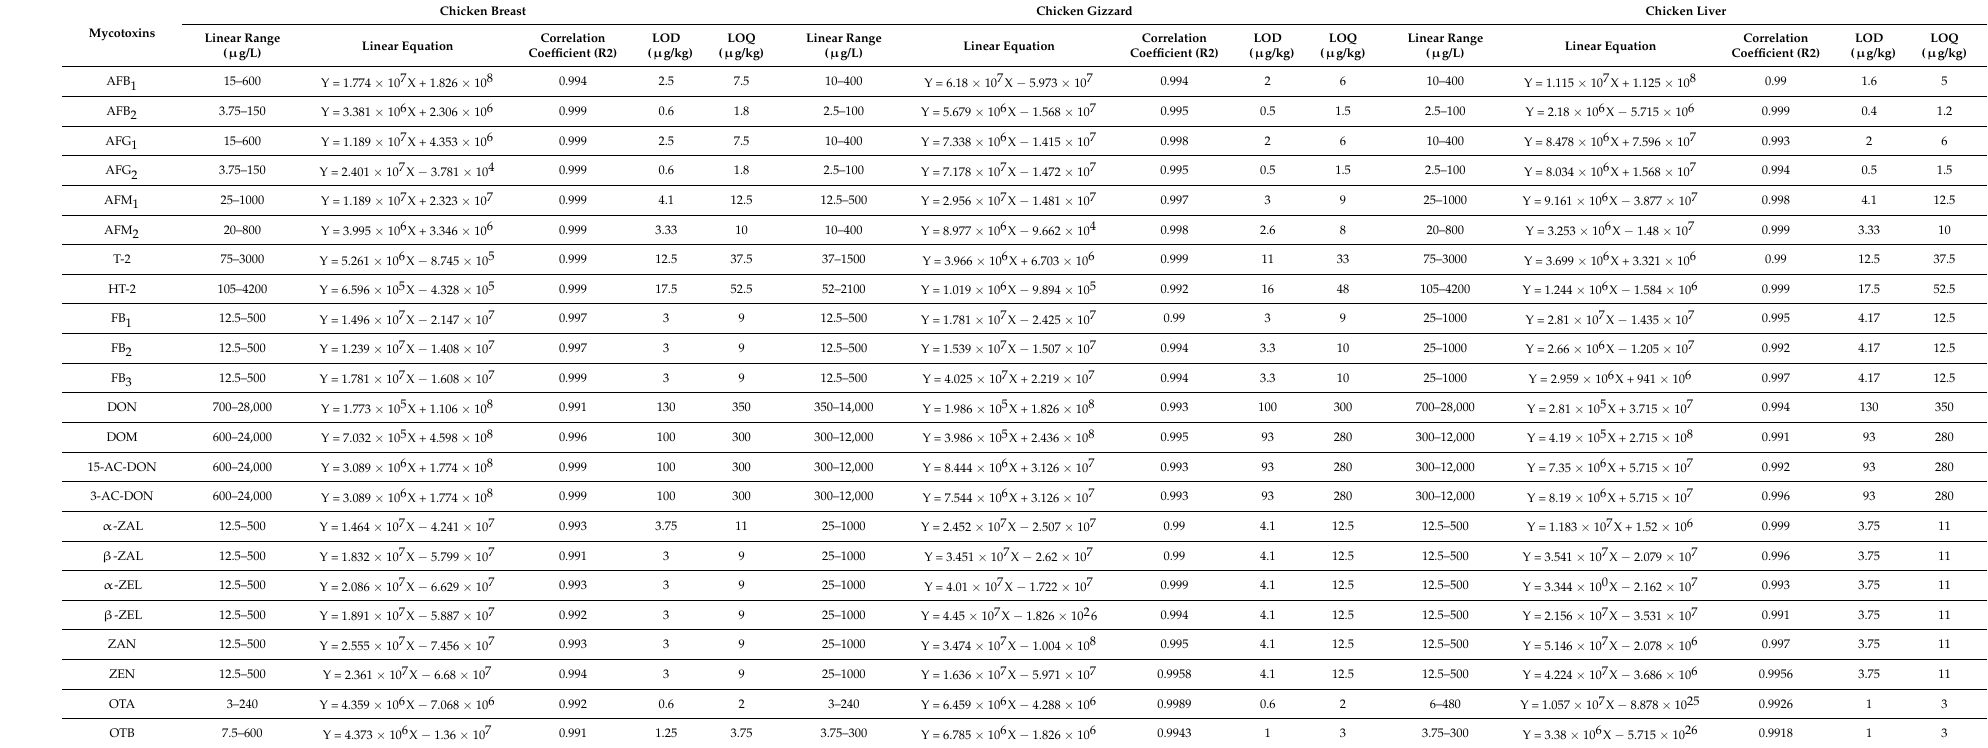
Table 5. Linear range, detection limit and quantification limit of 23